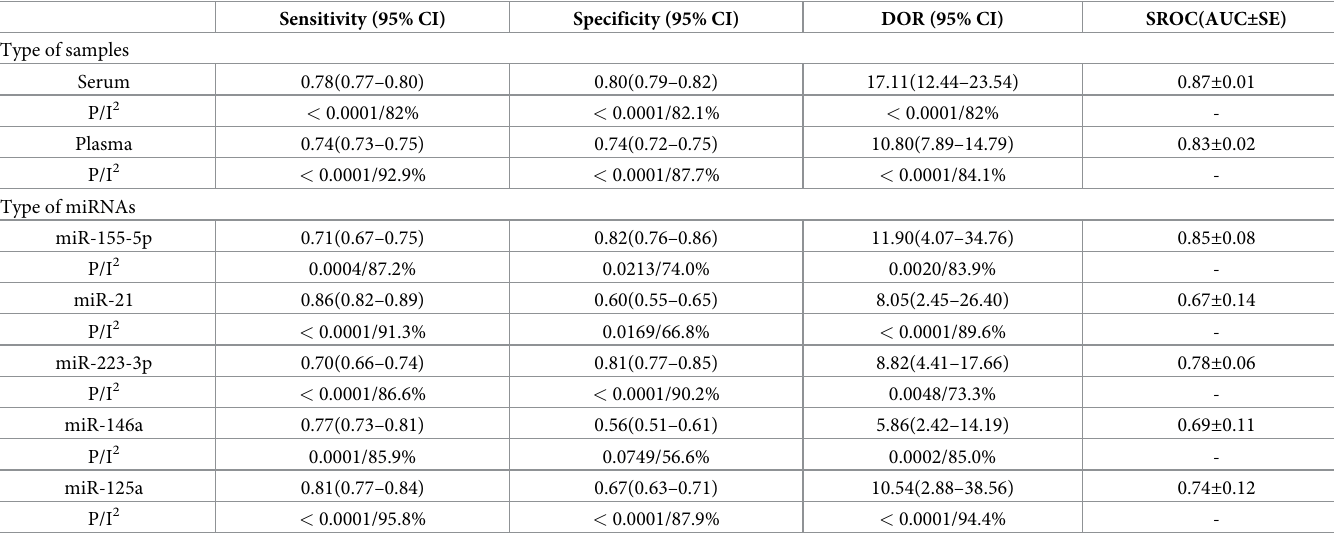
Table 2. Subgroup analysis results of included studies.